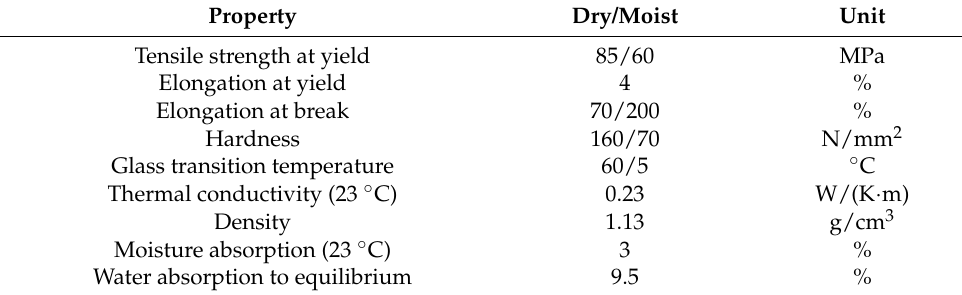
Table 1. The main characteristics of Polyamide